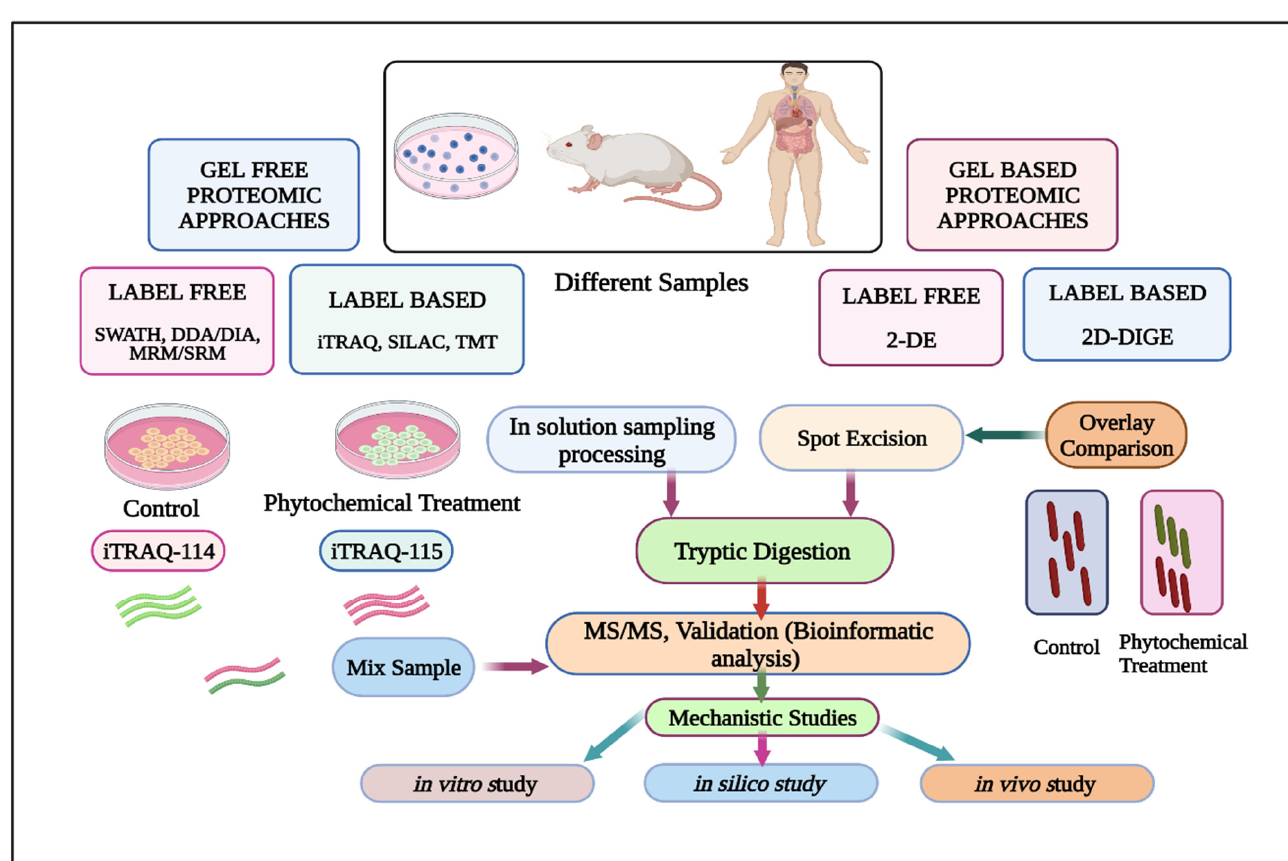
Figure 2. An overview of the proteomics strategies exploited to study the underlying intricacies for phytochemical-based therapeutic interventions. The figures are prepared with the BioRender Software (biorender.com). Abbreviations: SWATH: Sequential Windowed Acquisition of All Theoretical Fragment; DDA: Data-Independent Acquisition; DIA: Data-Dependent Acquisition; MRM: Multiple- Reaction Monitoring; SRM: Selective Reaction Monitoring; iTRAQ: Isobaric tag for Relative and Absolute Quantitation; SILAC: Stable Isotope Labeling by/with Amino acids in Cell culture; TMT: Tandem Mass Tag; 2-DE: Two-dimensional Electrophoresis; 2D-DIGE: Two-dimensional-Difference in Gel Electrophoresis; MS: Mass spectrometry.